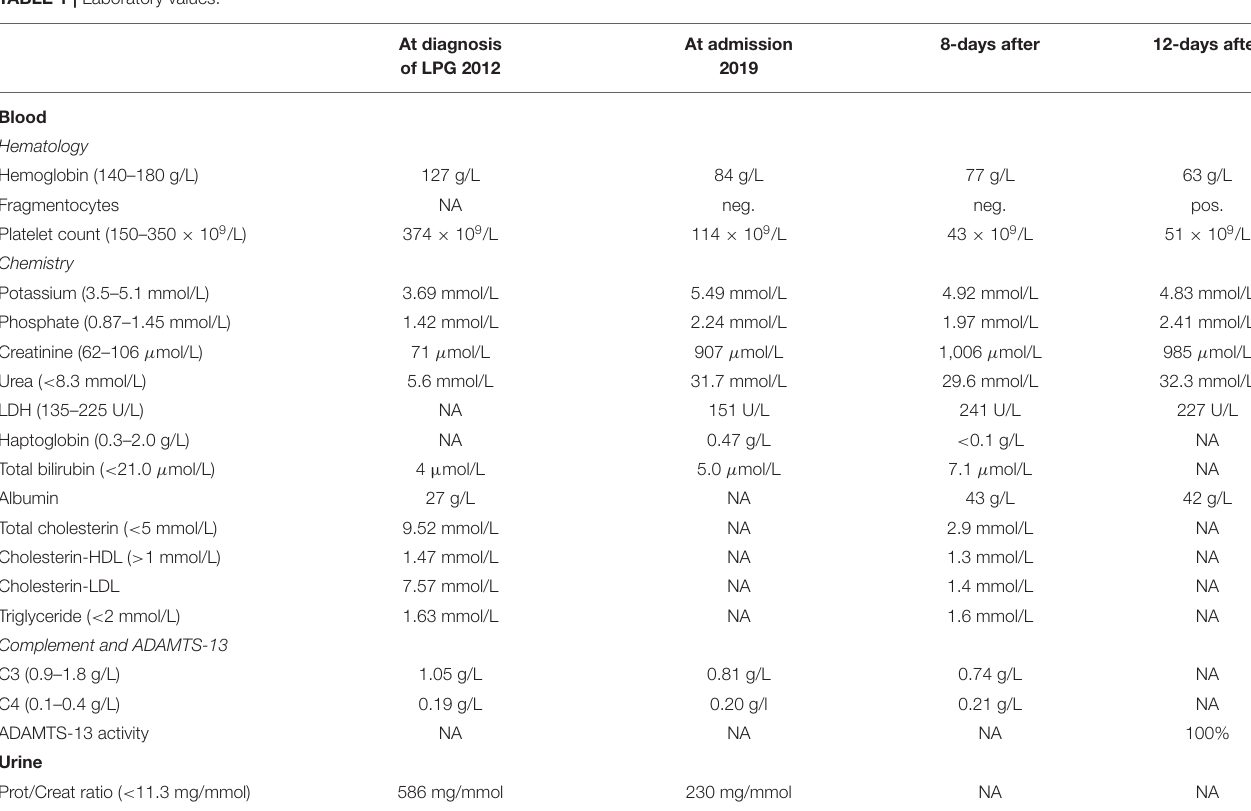
TABLE 1 | Laboratory